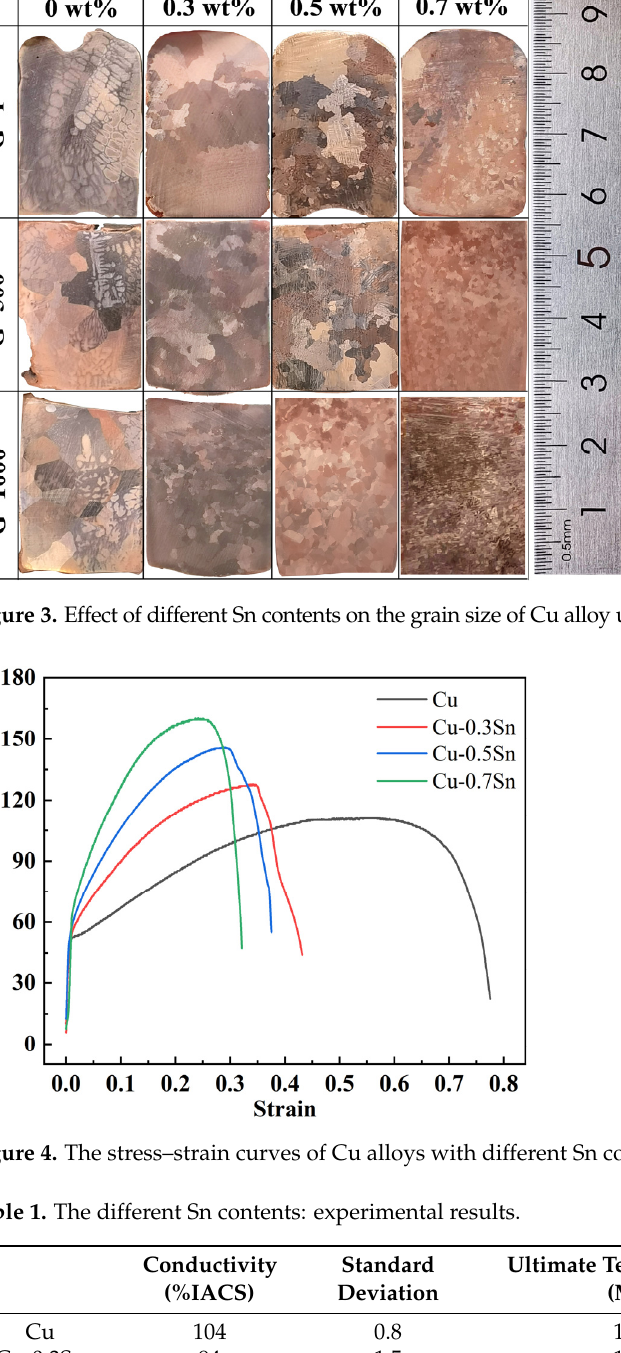
Figure 3. Effect of different Sn contents on the grain size of Cu alloy under different gravity coefficients.